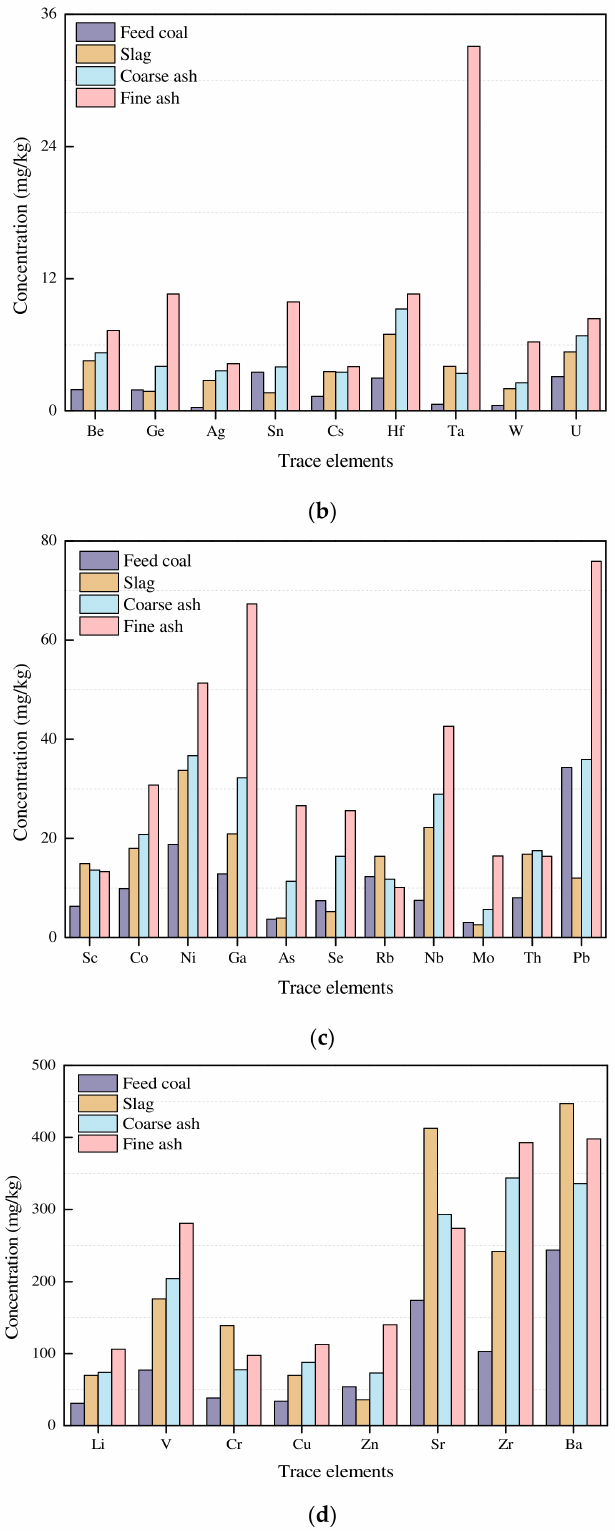
Figure 3. Comparison of trace elements with concentrations of lower than 5 mg/kg ( a ), 35 mg/kg ( b ), 80 mg/kg ( c ), and 500 mg/kg ( d ) in feed coal, slag, coarse ash, and fine ash from the WN power